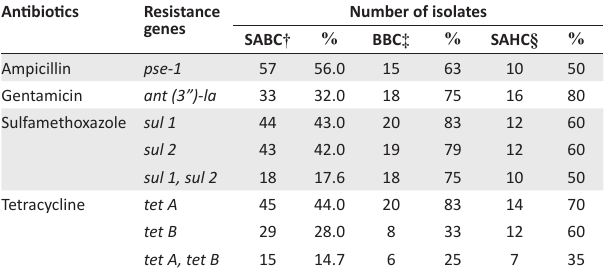
TABLE 7: Prevalence of antimicrobial resistance genes screened from 146 Salmonella isolates. Antibiotics